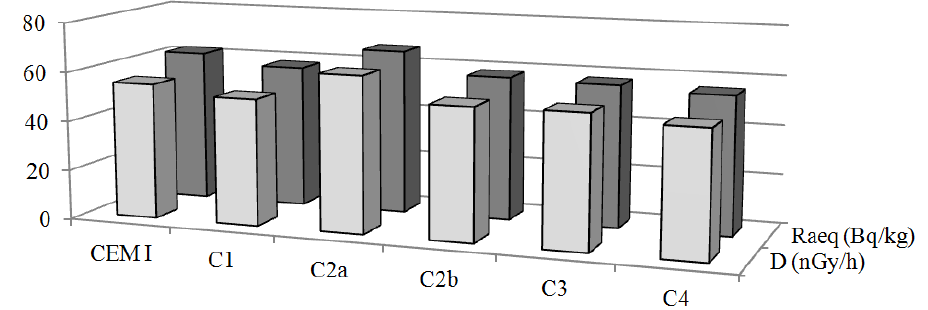
Figure 2. Comparison between the average values of radium equivalent Ra dose rate D for cement (used in composites) and cement